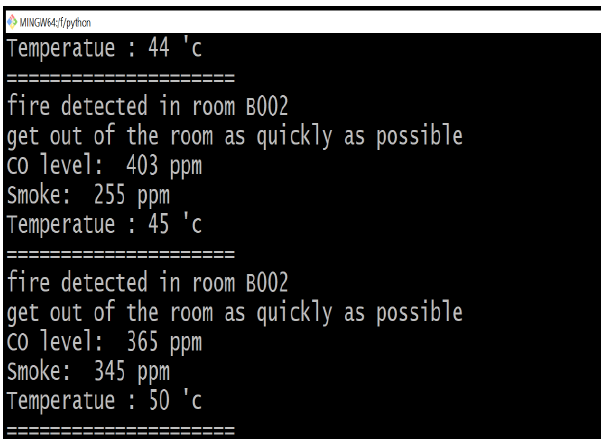
Figure 6. IFD transferring real-time data to the central server in case of fire